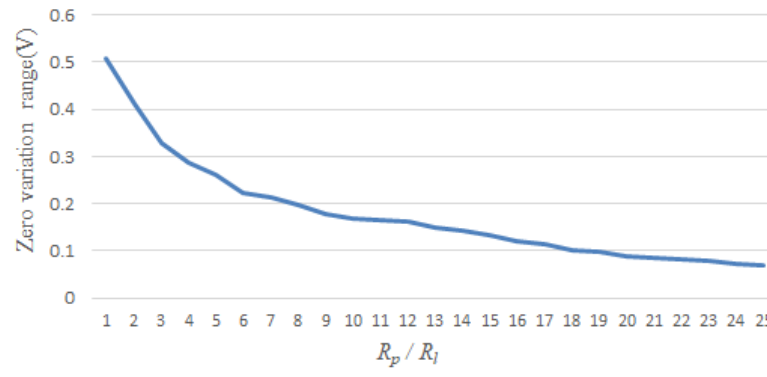
Figure 4. TGS-821 sensor’s zero value changes with R l variation.